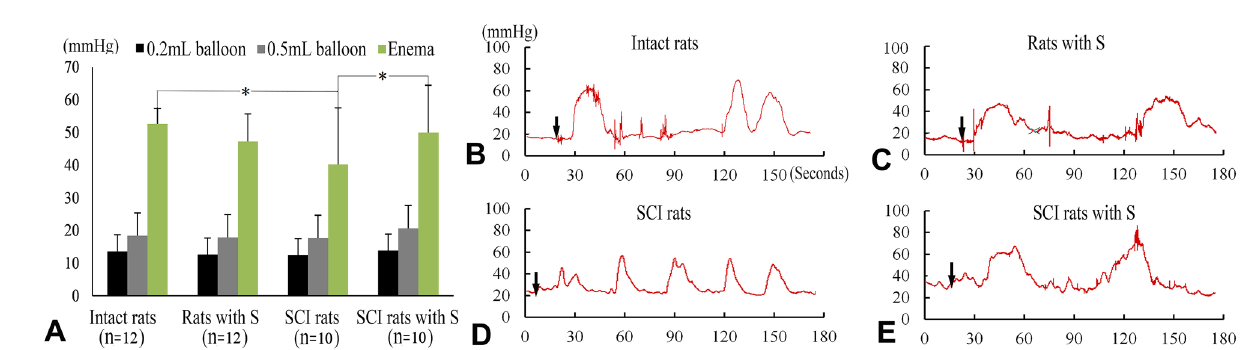
Figure 4. Distal colon pressure at four weeks after surgery. ( A ) Comparison of pressures among three pressure measurement modes. *Intact rats vs SCI rats and SCI rats with S versus SCI rats, P < 0 ⋅ 05 (two-way ANOVA). ( B – E ) Defecation reflexes, while the defecation reflexes occurred, the pressure waves were irregular ( B , C , and E ), but a rhythmic oscillation could occur in SCI rats ( D ). Black arrows indicate the time taken to give glycerin